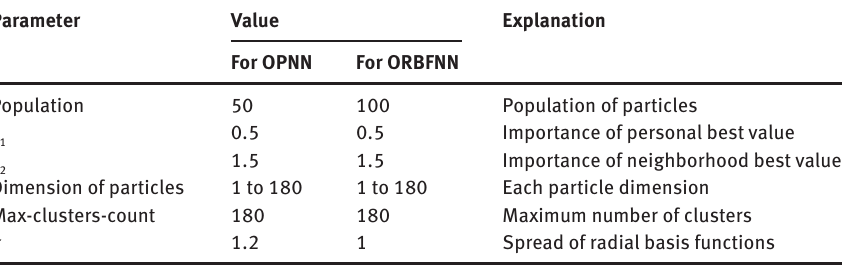
Table 2: Fine-tuned parameters of OPNN and ORBFNN.